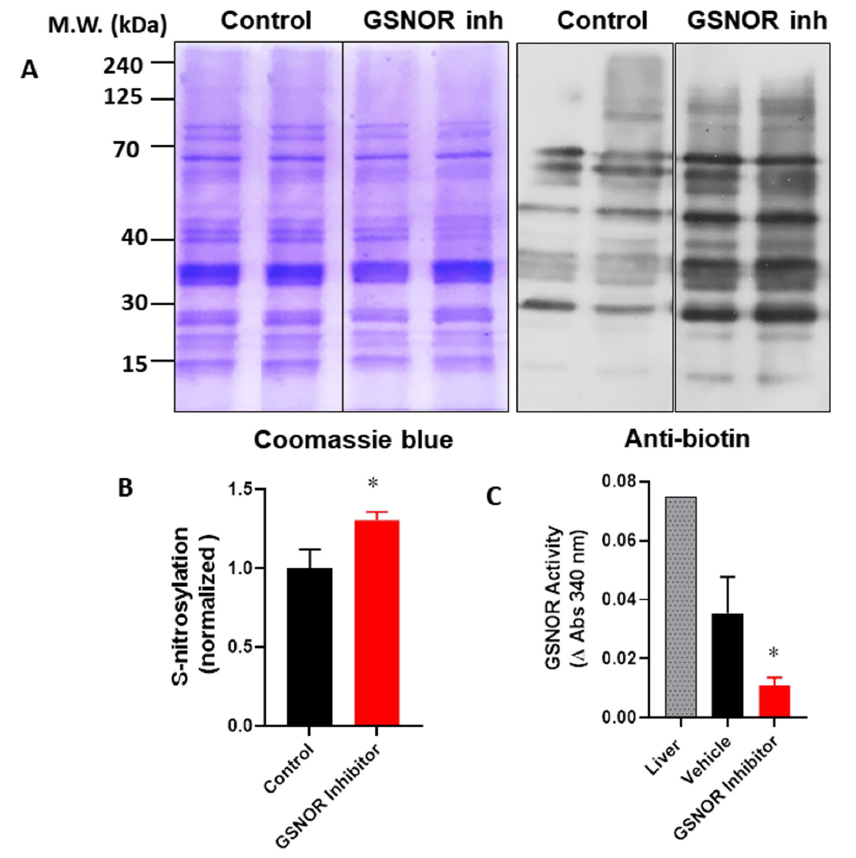
Figure 3. Impact of GSNOR inhibitor on global cardiac S-nitrosylation. Analysis of S-nitrosylated proteins from cardiac extracts of hearts submitted to ischemia reperfusion, treated with vehicle (control) or with the GSNOR inhibitor C2, 1 µmol/L. ( A ), left—representative images of a gel stained with Coomasie blue for total proteins submitted to the biotin switch process; right—a parallel Western blot of the same samples submitted to the biotin switch, probed with an anti-biotin antibody. ( B ), densitometric analysis for the intensity of the bands for anti-biotin ( n = 3 in each group). C , quantification of GSNOR enzymatic activity in control hearts and those treated with the GSNOR inhibitor C2, 1 µmol/L ( n = 3 in each group). Asterisk (*) indicates p < 0.05.